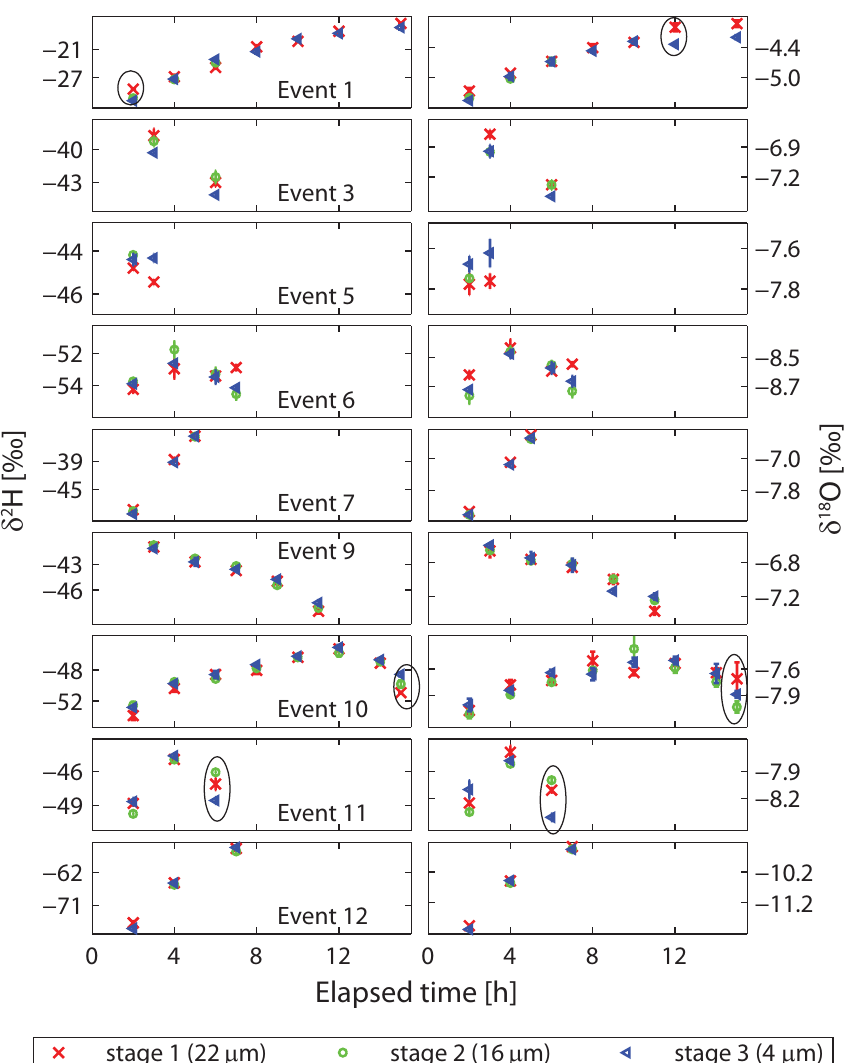
Fig. 3. Temporal evolution of the δ 2 H and δ 18 O values for all measured cloud events during HCCT lasting longer than one measurement point: δ values for the different stages are shown in different colors and different symbols and denoted with their cut-off diameters in brackets. Measurement error in terms of standard errors of the IRMS measurements are shown as error bars. Cloud samples exceeding the 1 st 90- percentile threshold (see Fig. 4 for further details) are marked with an ellipse. Identification of the drivers of this temporal evolution as well as interpretation is presented in Spiegel et al.